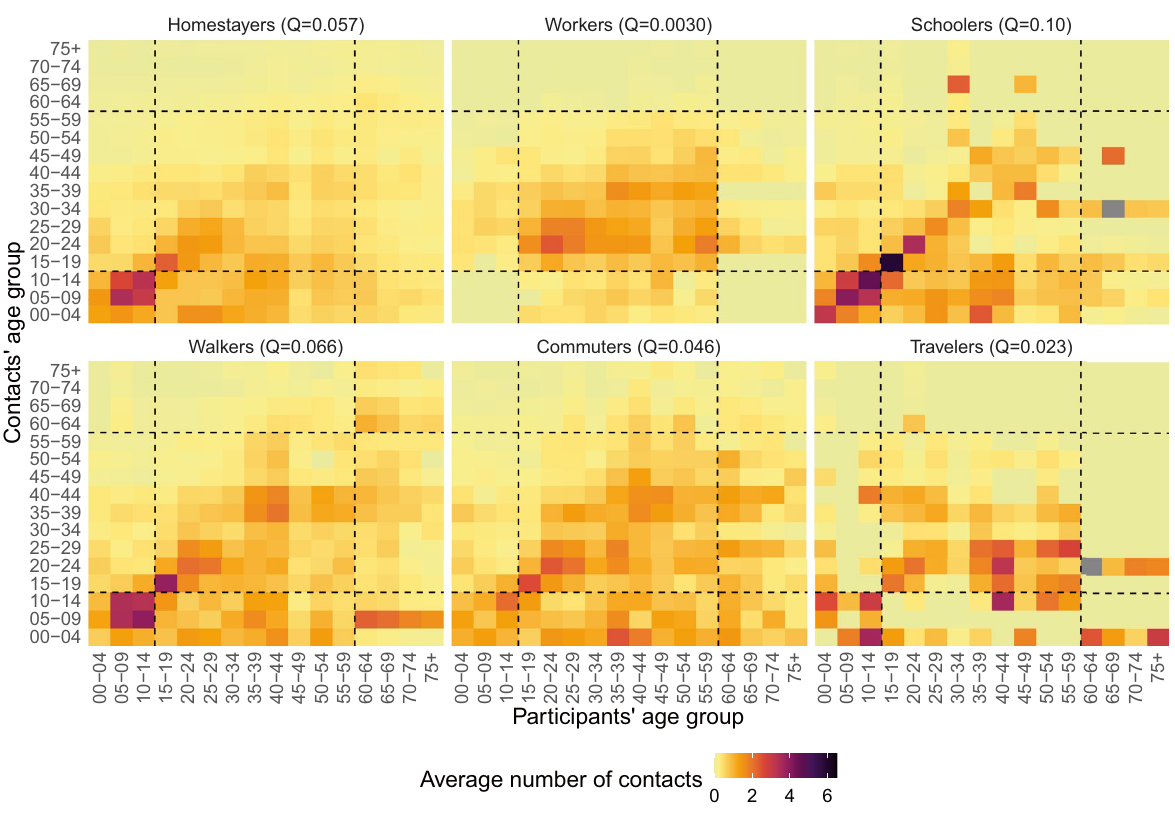
Figure 4. Average number of overall contacts between participants in age class i and contacted individuals in age class j , adjusting for reciprocity of contact at the population level, stratified by TU profile. The dashed lines help identifying the contacts of children (0–14 years), teens and adults (15–59 years) and older adults (60 + years). At the top of each matrix, we report its assortativeness index